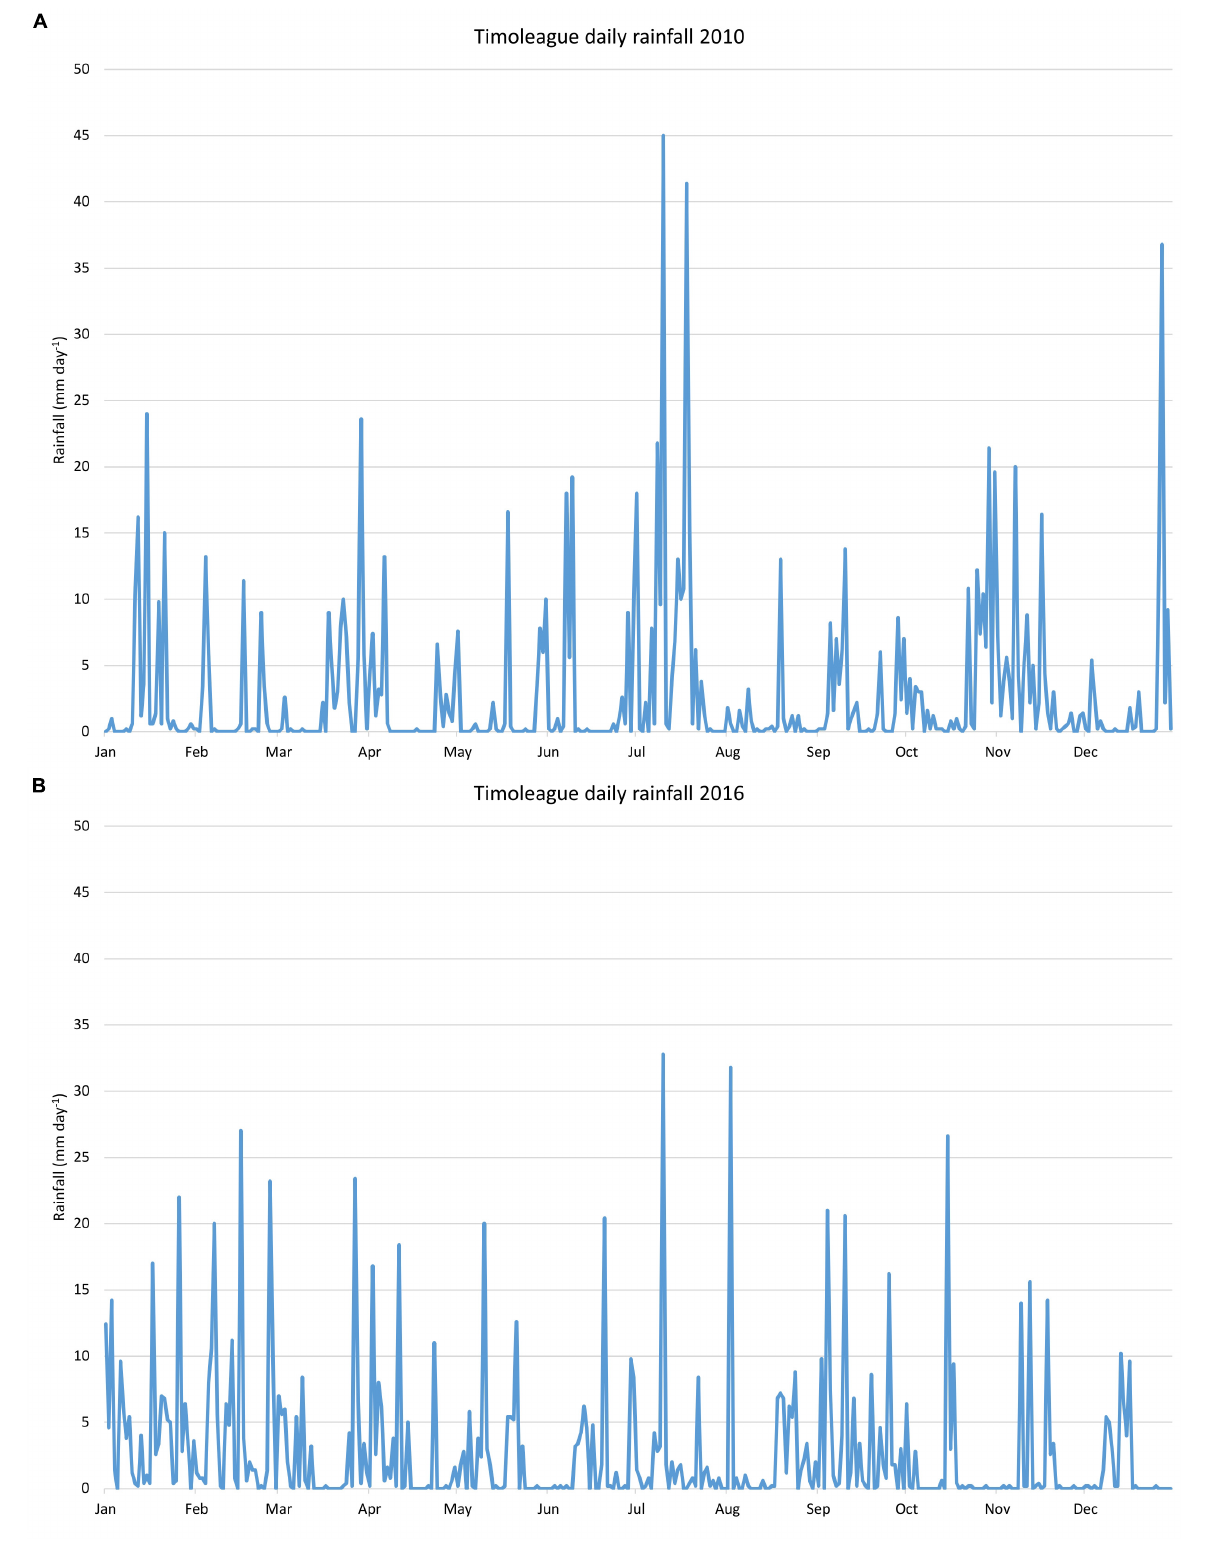
Frontiers in Marine Science |